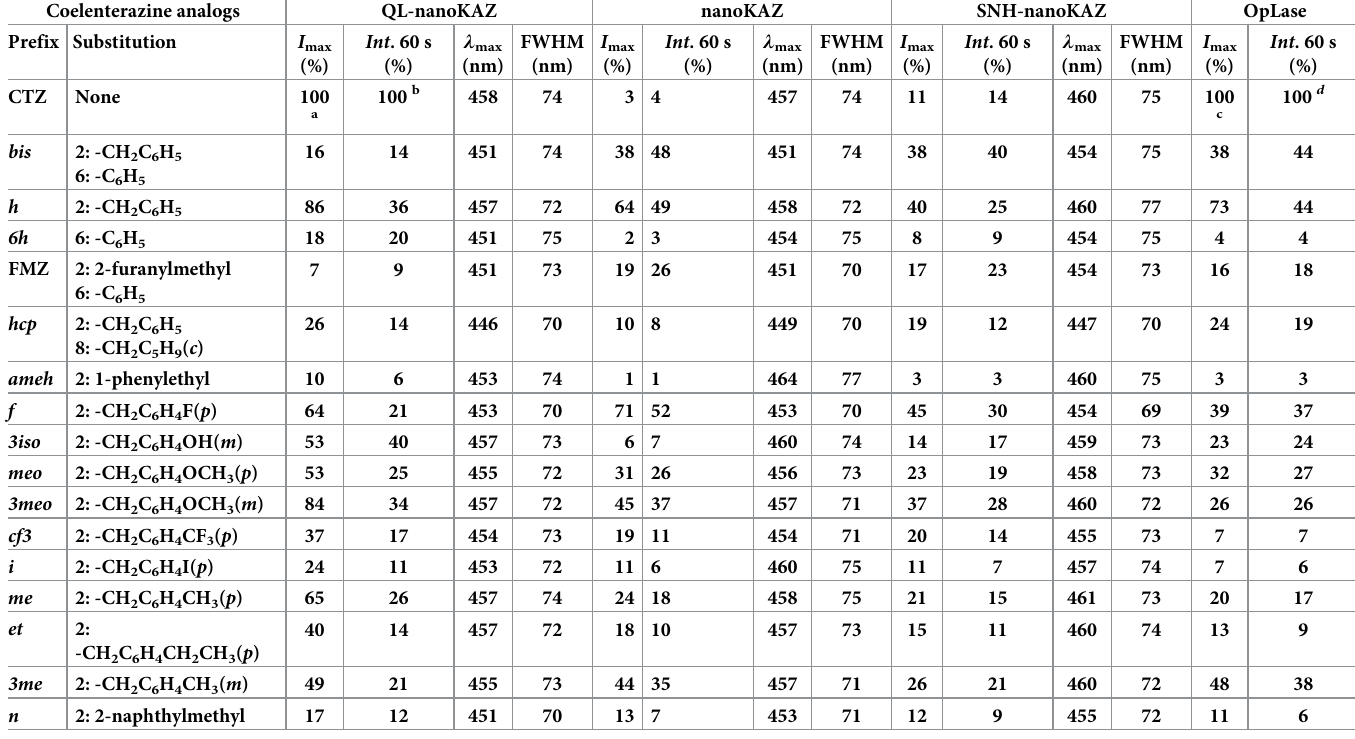
Table 7. Substrate specificities and luminescence properties for purified QL-nanoKAZ, nanoKAZ, SNH-nanoKAZ, and native Oplophorus luciferase (OpLase). Coelenterazine